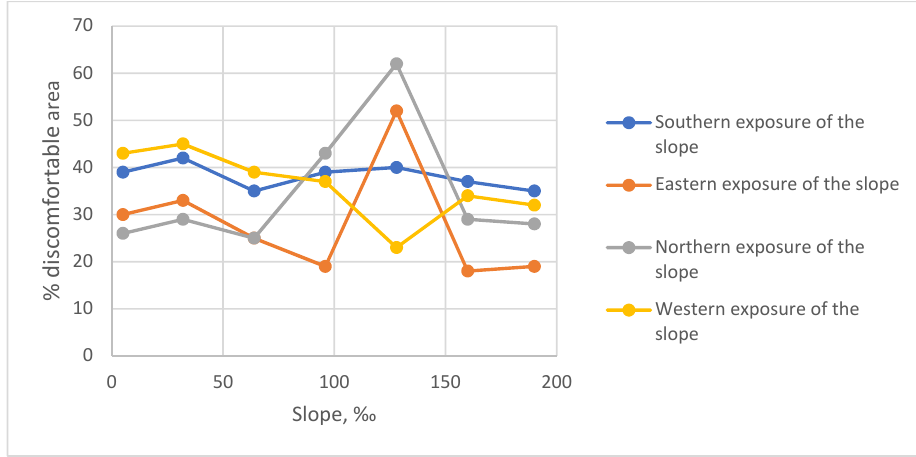
Figure 13. Dependence of k on the slope gradient for the ribbon development.